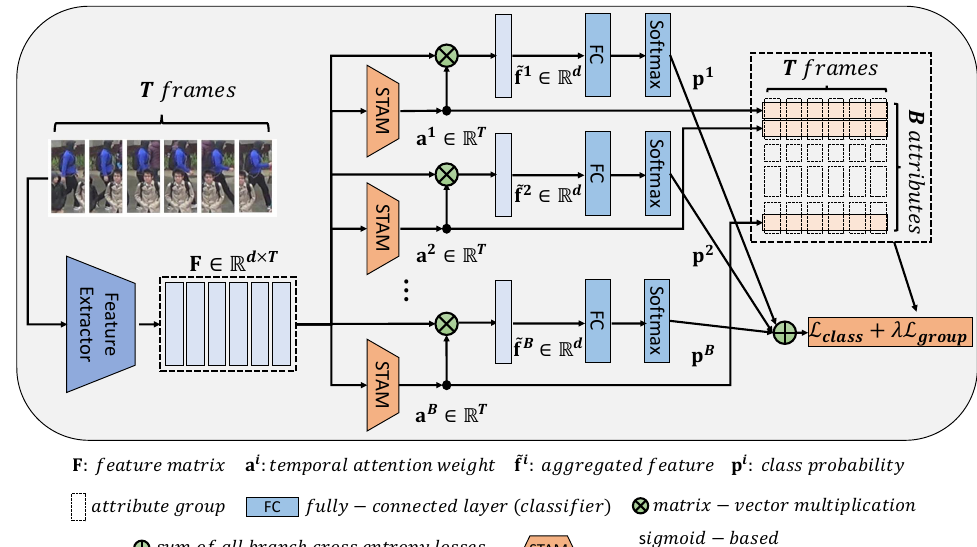
Figure 2. Overview of the network architecture of the proposed method. It comprises a feature extractor, Sigmoid-based temporal attention modules, and attribute classifiers. Due to the fact that the attributes of the pedestrians are closely related to each other, the attention weights for semantically adjacent attributes have similar values to each other, i.e., temporal frame attentions are not independent. To reflect this point, we formulate a temporal attention module based on the group-sparsity constraint. In the T × B block, the attention weights of the related attributes are grouped by the L 2 norm in each